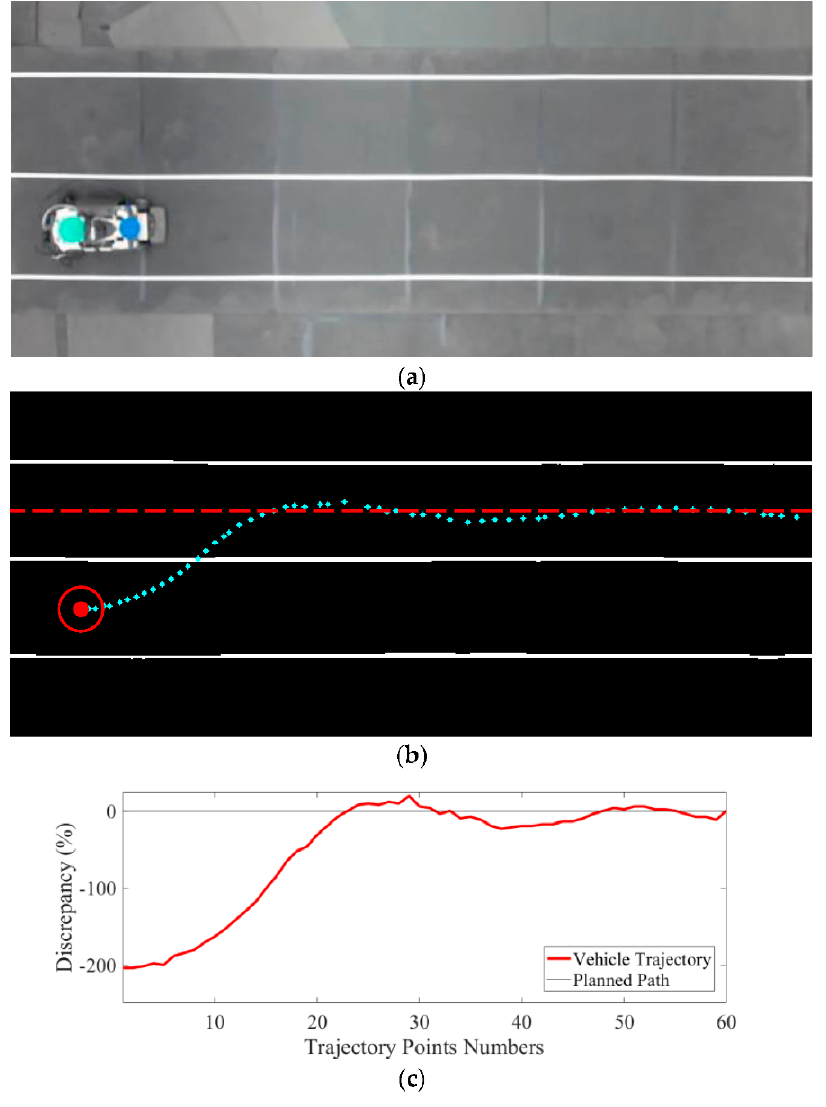
Figure 9. ( a ) Experimental verification of the improved RRT algorithm in the lane change and lane keeping of an autonomous vehicle, ( b ) the vehicle trajectory in lane change and lane keeping, and ( c ) the trajectory discrepancy within 8.3% of vehicle width after the lane change.